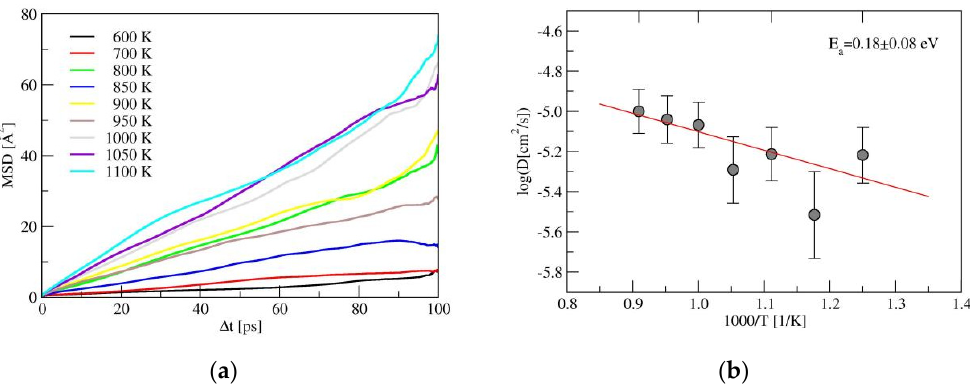
Figure 6. ( a ) The MSD for Li + ions simulated by AIMD, and ( b ) Arrhenius plot of diffusion coefficients for amorphous-LiSiON.